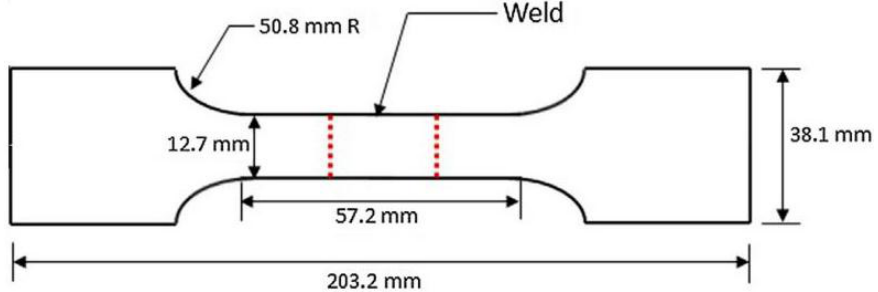
Figure 4. Schematic diagram of tensile specimens.